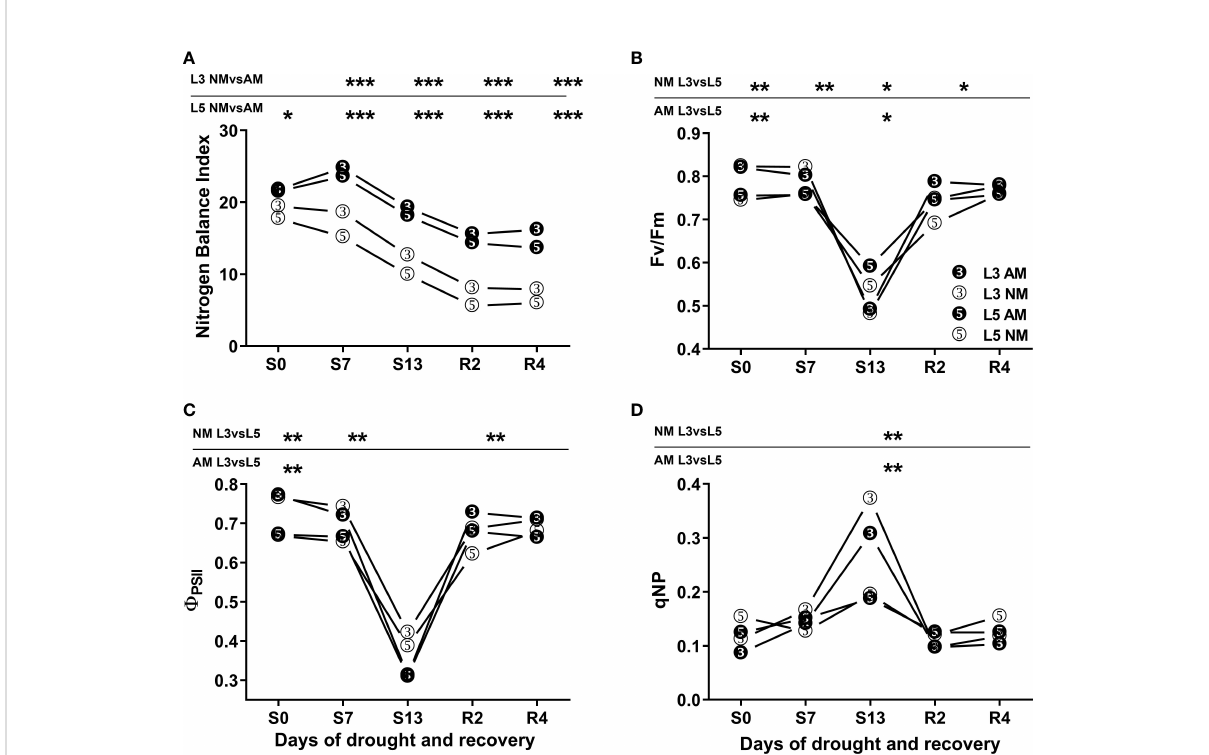
FIGURE 1 Nitrogen Balance Index (NBI) (A) and photochemical ef fi ciency (B-D) of upper (L3) and middle (L5) leaves of mycorrhized (AM) or non- mycorrhized (NM) plants during following days of water treatment. The values represent fully irrigated variants (S0), days of drought (S7, S13) and rehydration (R2, R4). F PSII – effective quantum yield of PSII electron transport, Fv/Fm - maximum PSII quantum yield potential, qNP – non- photochemical quenching of chlorophyll a fl uorescence. Asterisks denote statistically signi fi cant differences between AM and NM means (n=50) for NBI values, and between L3 and L5 means (n=6) within each symbiotic variant for photosynthetic indices. Statistics were calculated according to Students t-test (* p <0.05, ** p <0.01, *** p <0.001), standard deviation values were less than 15% and were omitted for